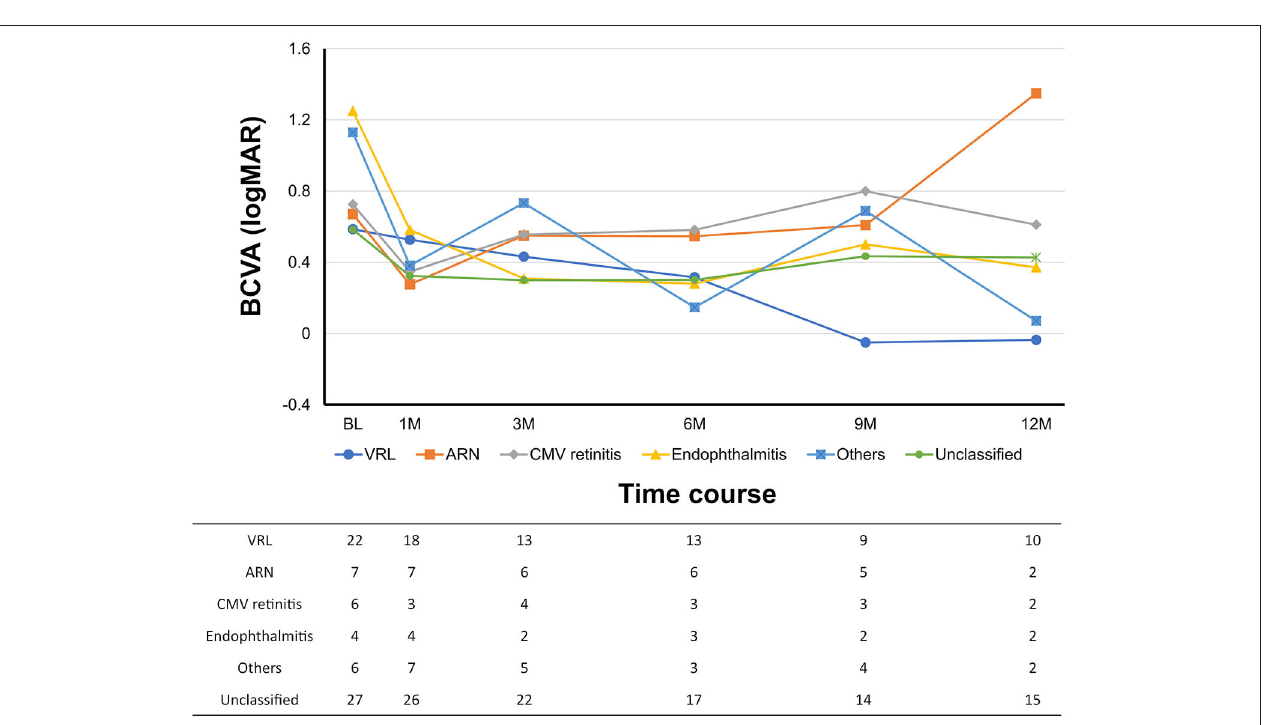
follow-up time after PPV (14.6 months). The reason for the older age at time of PPV in our study could be attributed to the smaller number of eyes with young-onset uveitis. In Henry’s review, Behçet’s disease and juvenile idiopathic arthritis accounted